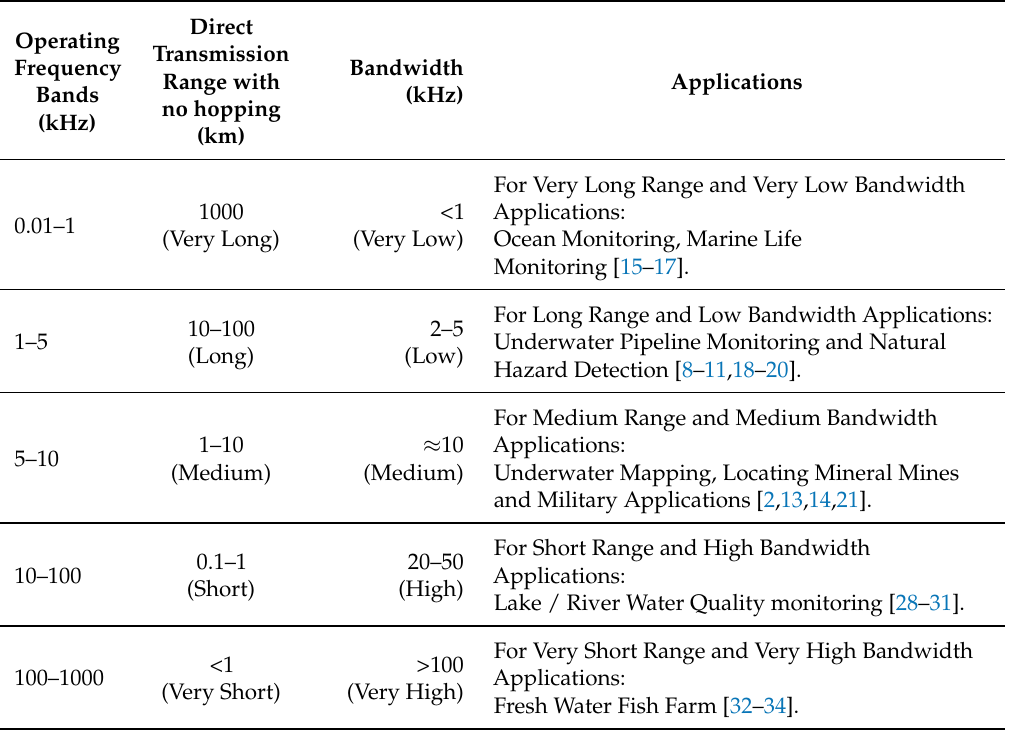
Table 1. Acoustic Channels of UWSN in terms of operating frequency band, bandwidth, direct transmission range, and applications